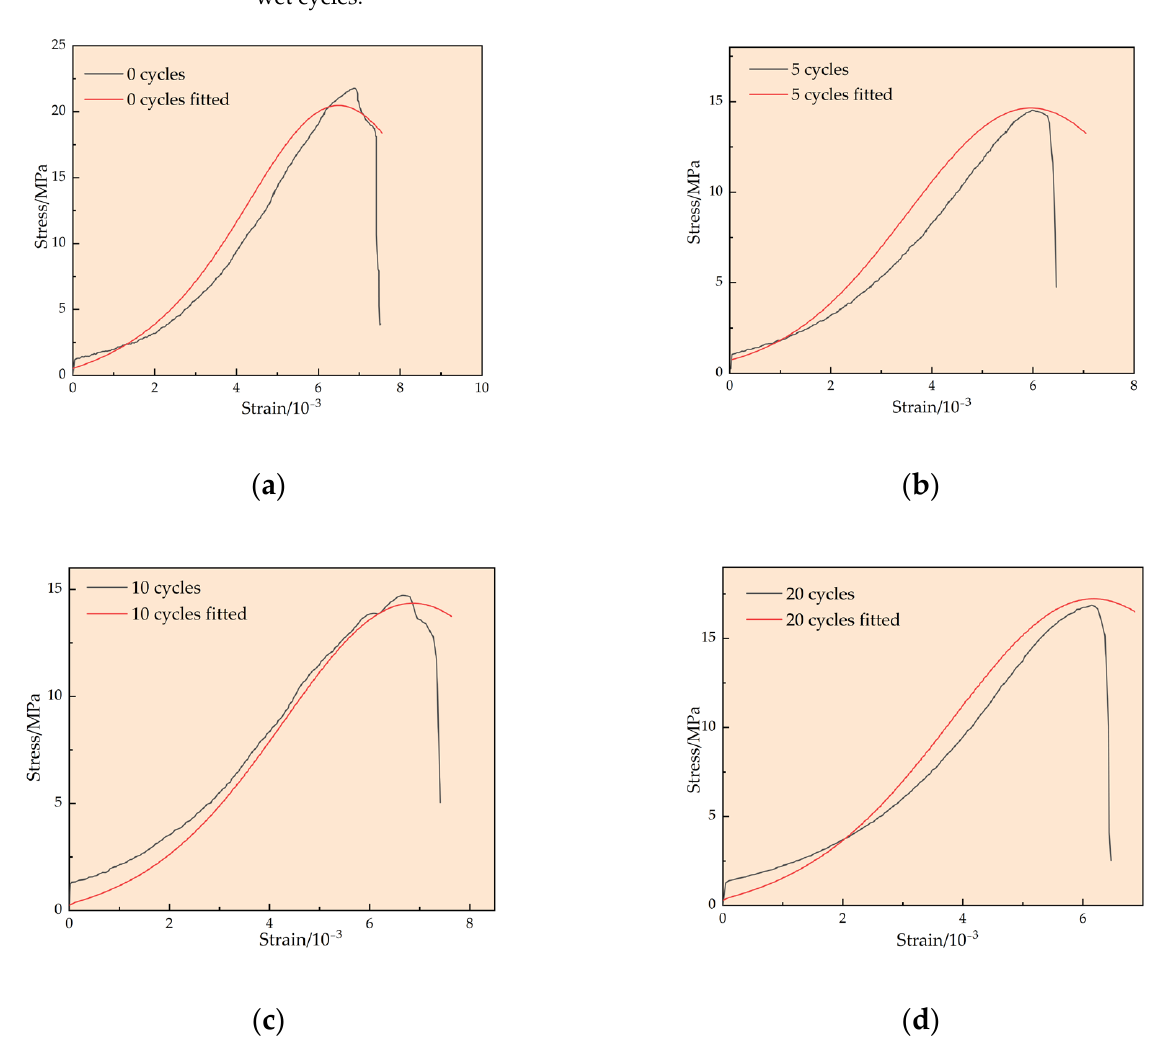
Figure 10. Theoretical stress–strain curves of fracture-grouted rock specimens with different numbers of dry and wet cycles. ( a ) 0 cycles. ( b ) 5 cycles. ( c ) 10 cycles. ( d ) 20